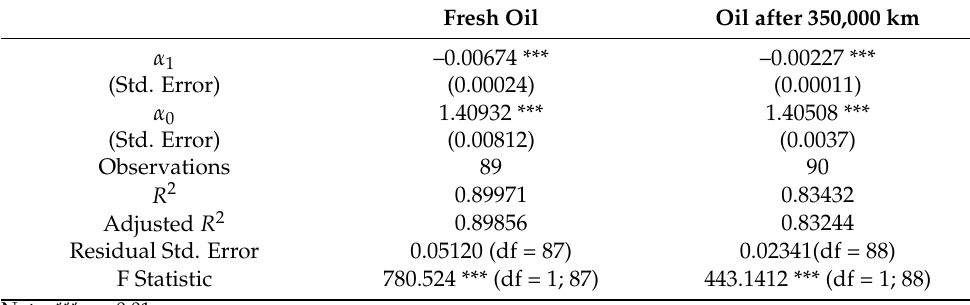
Table 3. Basic parameters of the linear regression model for oil 75W-140.